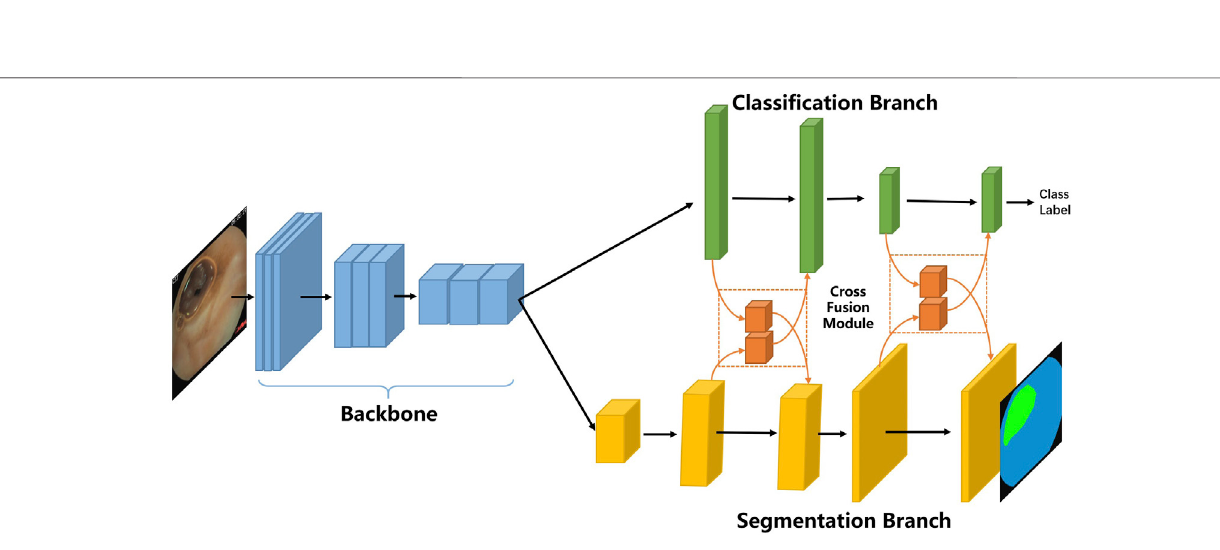
FIGURE 2 | Multi-task classi fi cation and segmentation network (MTCSN)